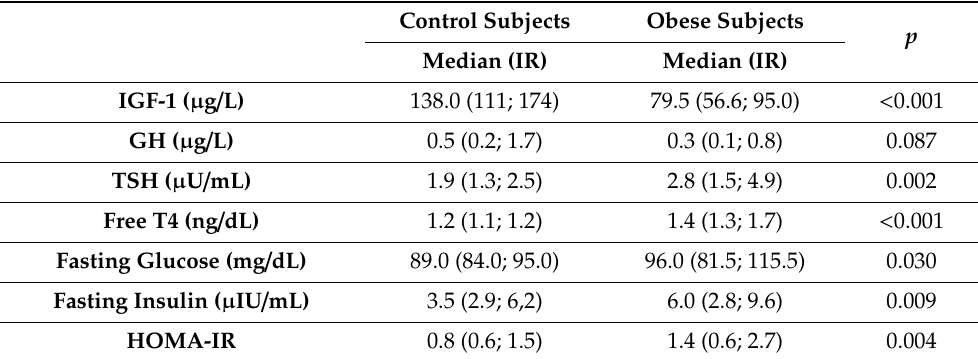
Table 2. Biochemical and hormonal data in control subjects and obese patients.